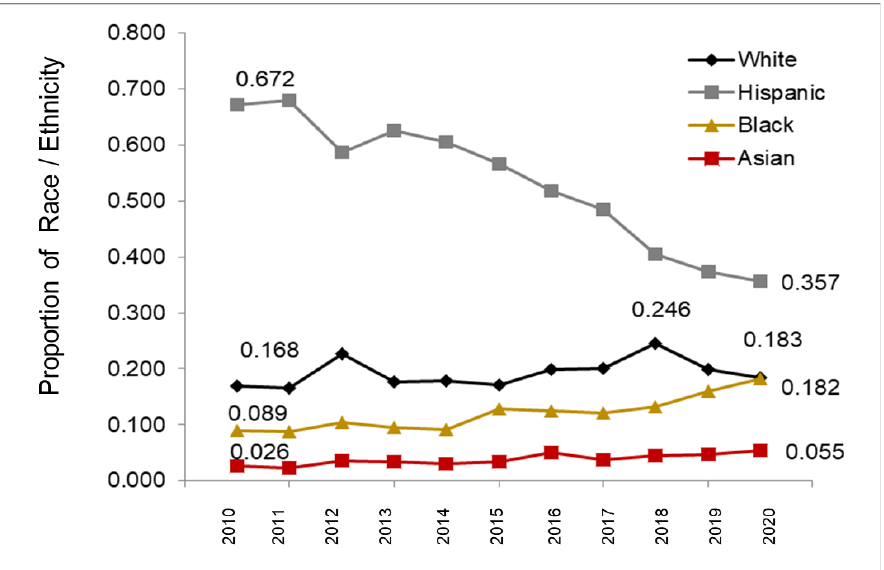
proportion of Black patients increased over time from 8.9% (2010) to 18.2% (2020), similar to the trend observed with Asians (2.6%, 2010 to 5.5%, 2020).